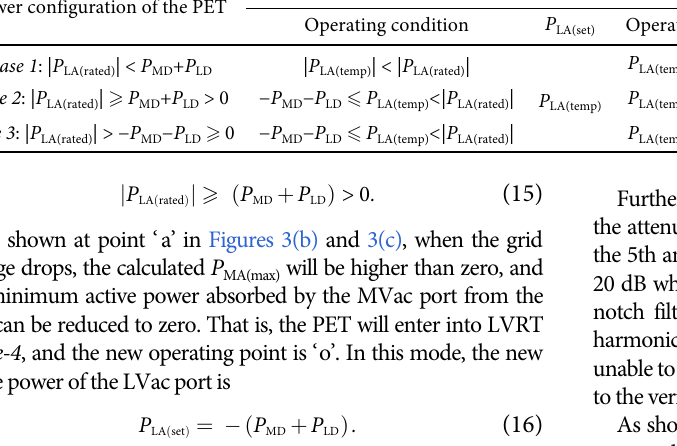
Table 1 Operating condition of each LVRT mode in the power-generation state Power configuration of the PET